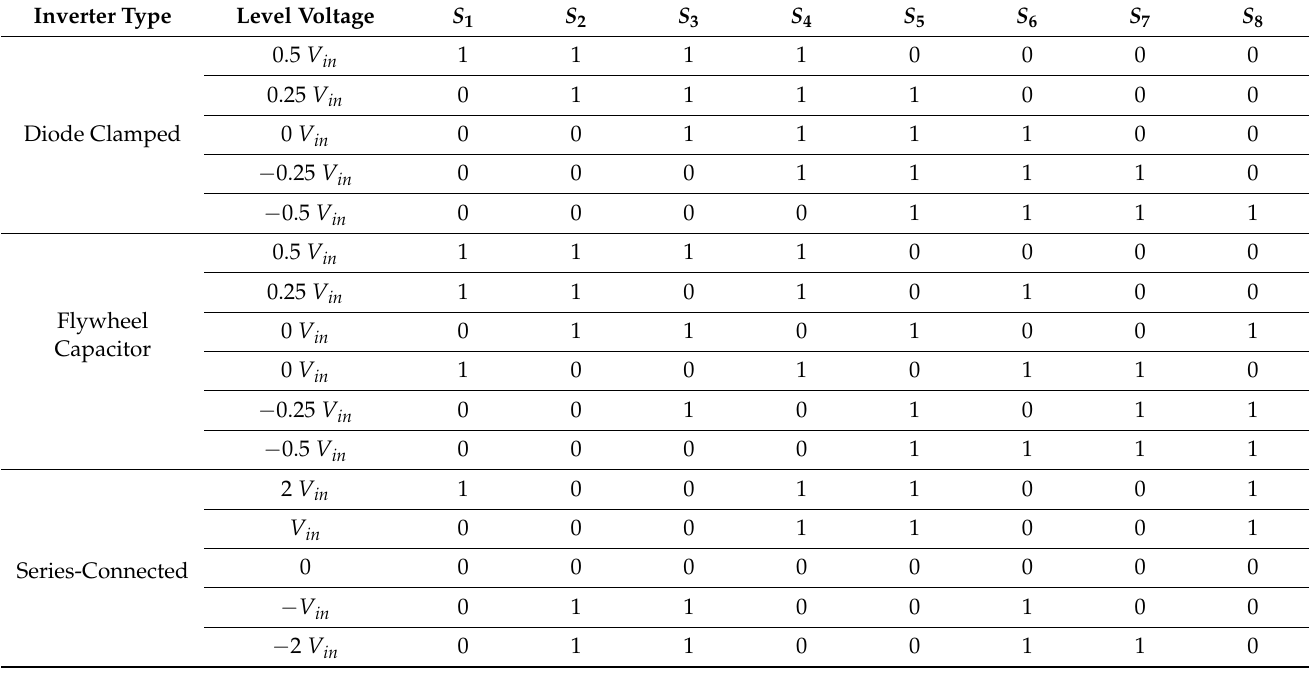
Table 1. Switching status and output voltage of the systematic five-level MLIs (1: ON; 0: